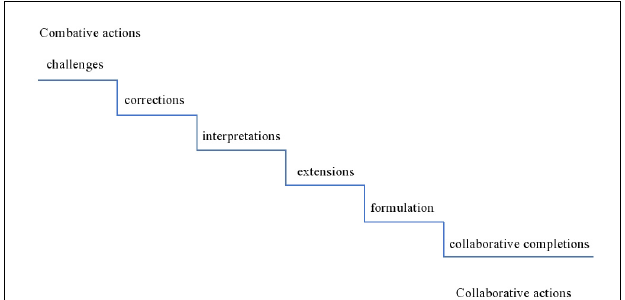
FIGURE 1 | Gradient of therapist’s combative to collaborative practices (Antaki,